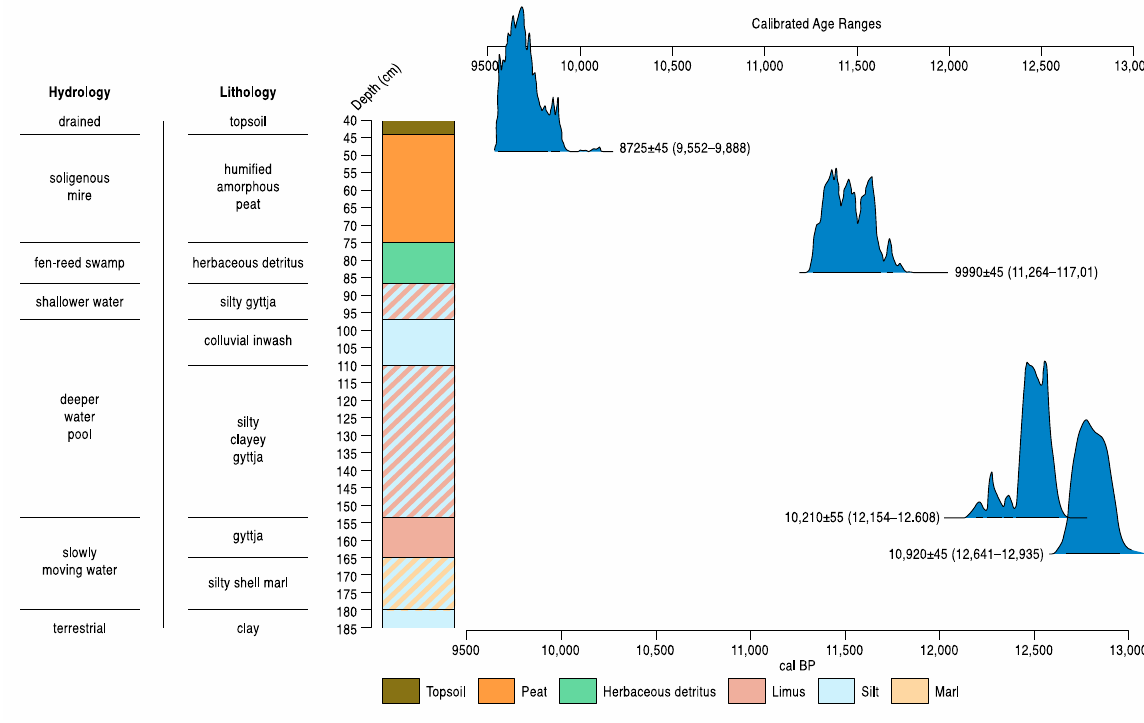
Figure 8. Conspectus of lithostratigraphy, chronology and hydrological history at Nosterfield the Flasks core 69. For lithology see Table 3. For dating details, see Table 1. Table 4. Altitudes (m a.s.l.) of palaeochannels of the Ure between Marfield and Ripon South. Approximate ages are interpolated from radiocarbon or pollen